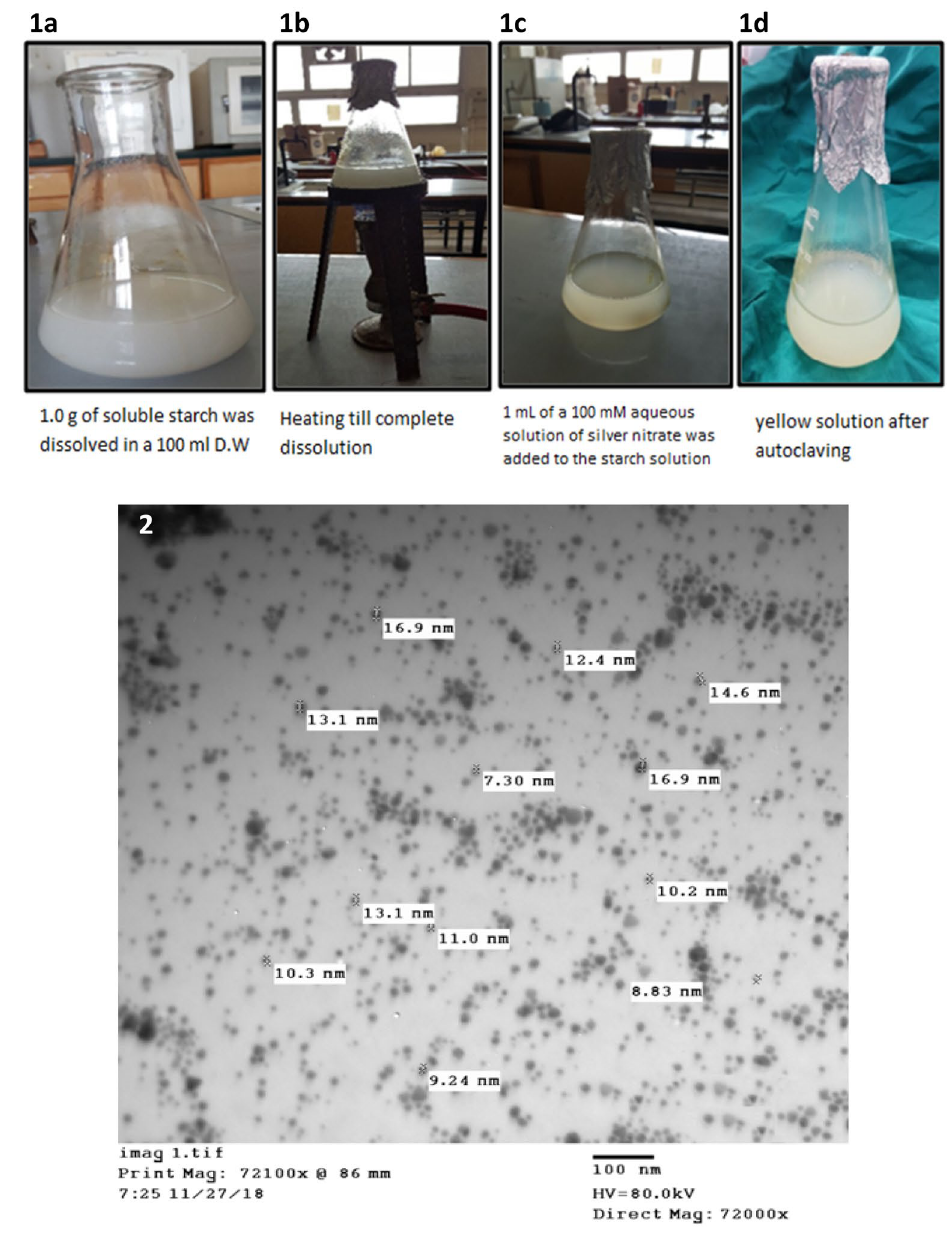
Figure 1. Preparation of the silver nanoparticles in the lab ( a–d ), and image of AgNPs under the electron microscope